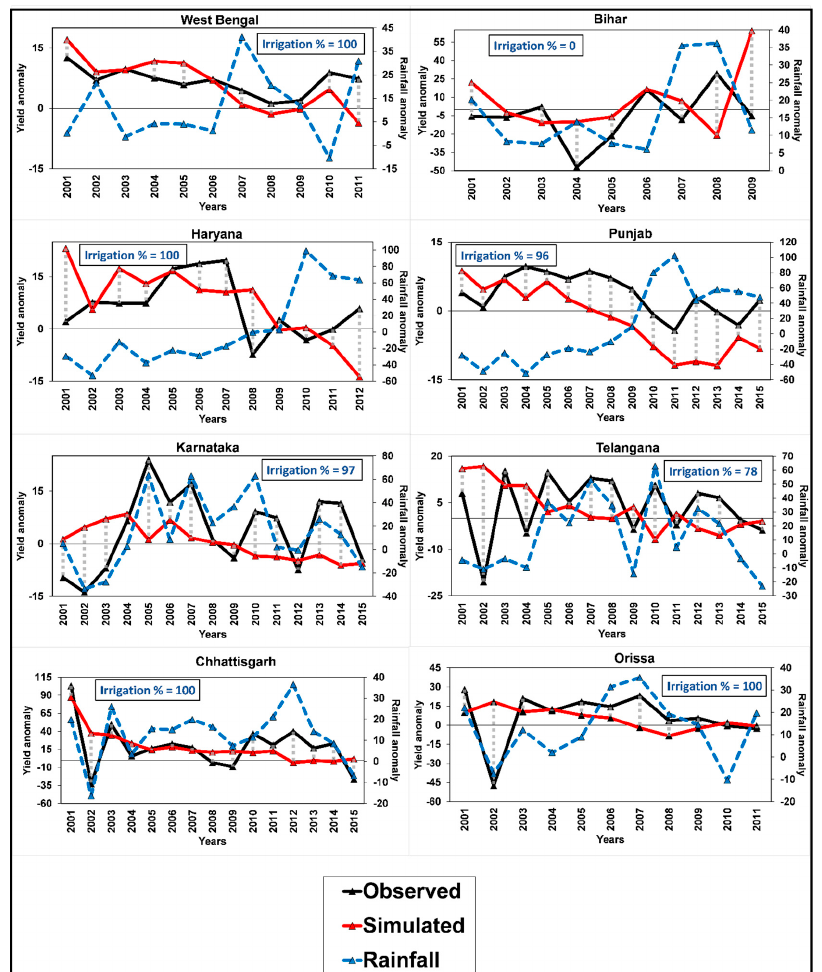
Figure 6. Time series of observed and simulated yield anomalies and rainfall anomalies. Curves are observed yield anomalies (Observed, black), simulated yield anomalies (Simulated, red), and rainfall anomalies (Rainfall, blue). The left Y -axis represents the observed and simulated yield anomalies; the right y -axis represents the rainfall anomaly. Years are on the X -axis. The grey dotted lines show the error between observed and simulated yield anomalies.